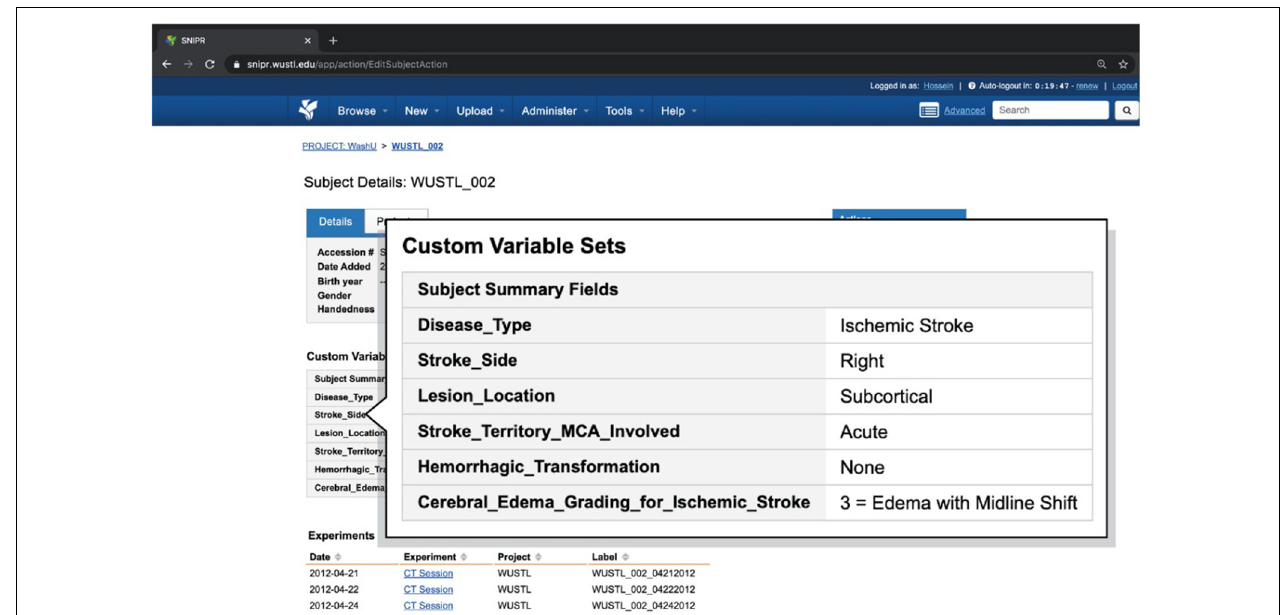
FIGURE 6 | SNIPR can manage clinical data and imaging CT session studies for each subject. Each patient has a subject page where user can have access to patient’s imaging visits and also patient’s clinical data in subject summary table.